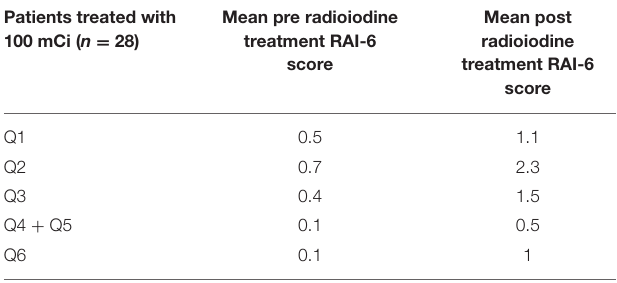
TABLE 5 | Pre- and post-operative mean RAI-6 scores in patients who received 100 mCi. Patients treated with 100 mCi ( n = 28)